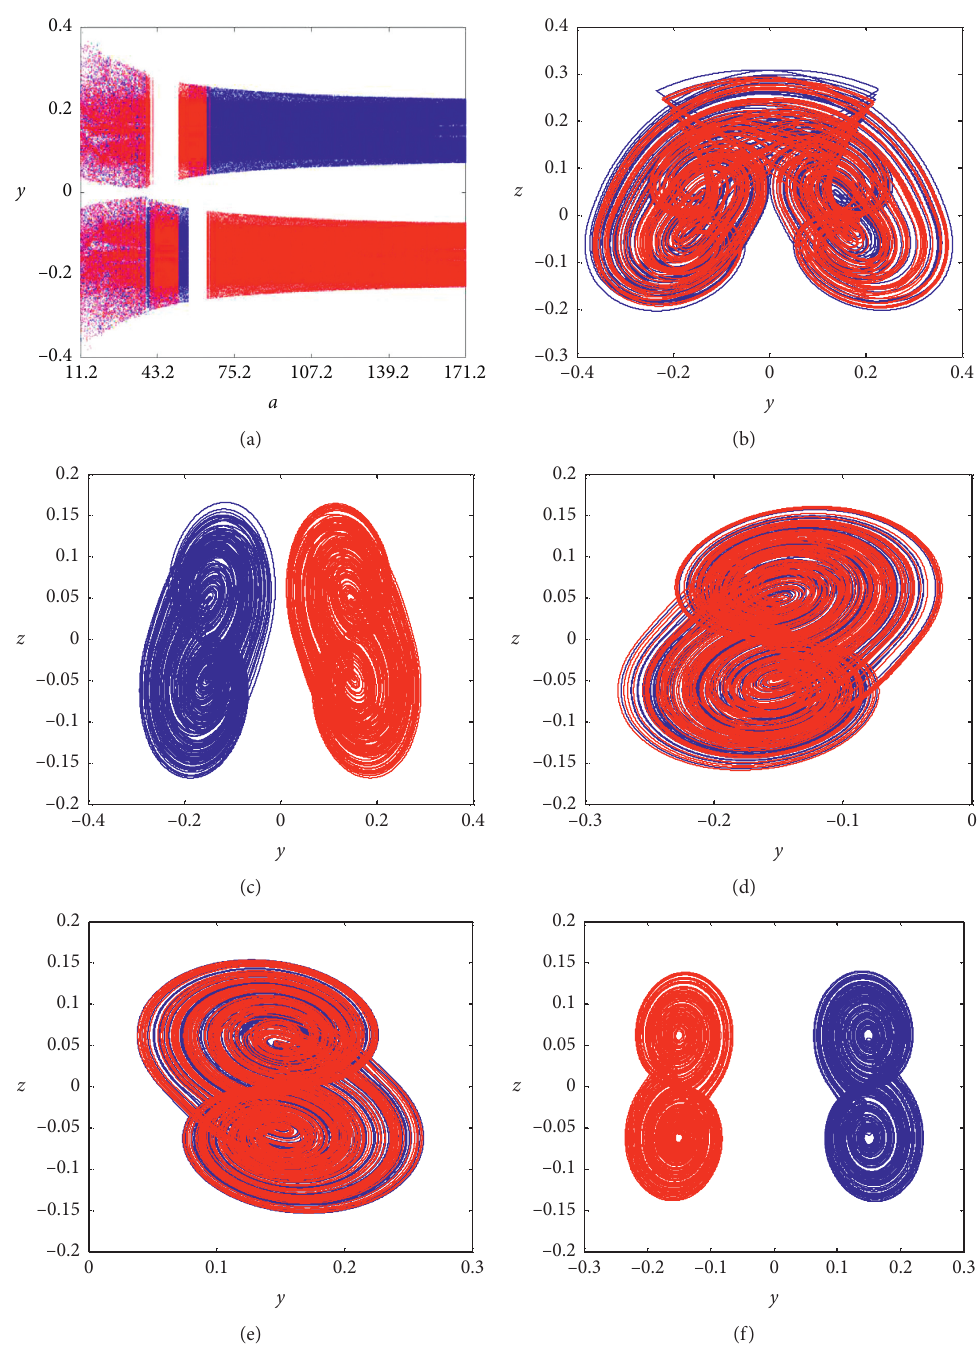
Figure 4: Numerical simulations for the proposed multiscroll chaotic system under mode 1: M ( − , +) with variation of a under the initial condition ( x 0 , y 0 , z 0 , w 0 ) � (0.01, 0.01, 0.01, 0.01) (blue case) and ( x 0 , y 0 , z 0 , w 0 ) � (0.01, − 0.01, − 0.01, 0.01) (red case). (a) Bifurcation diagram, (b) a � 19.2, (c) a � 40, (d) a � 48, (e) a � 60.8, and (f) a �